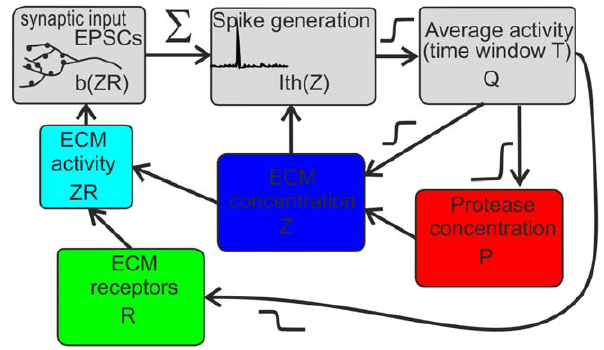
Figure 3. Schematic illustration of ECM-induced homeostatic regulation of average activity (see details in the main text).